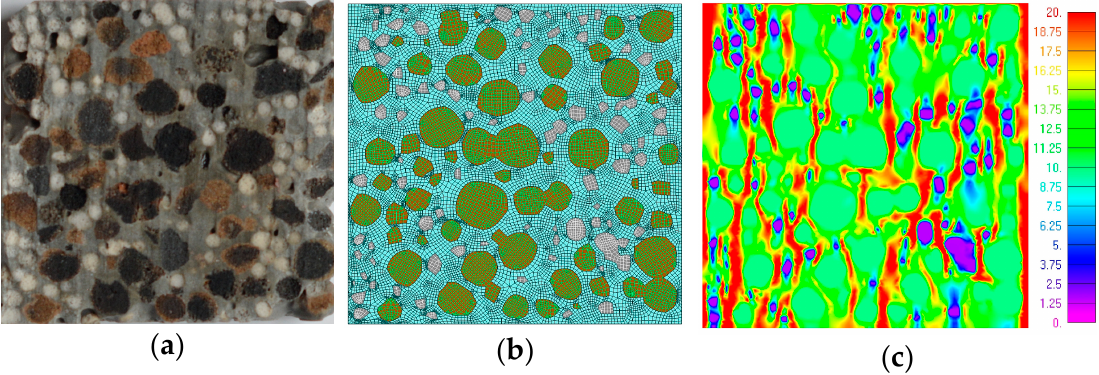
Figure 10. Specimen LWC 13: ( a ) section; ( b ) FEM model; and ( c ) FEM results (MPa).